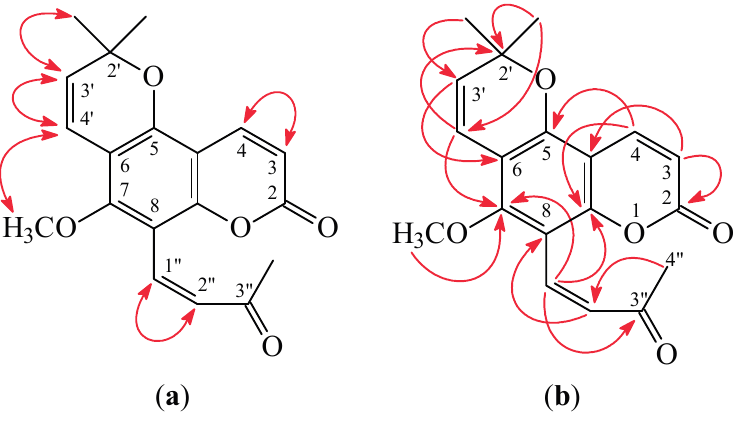
Figure 5. Key NOESY ( a ) and HMBC ( b ) correlations of 3